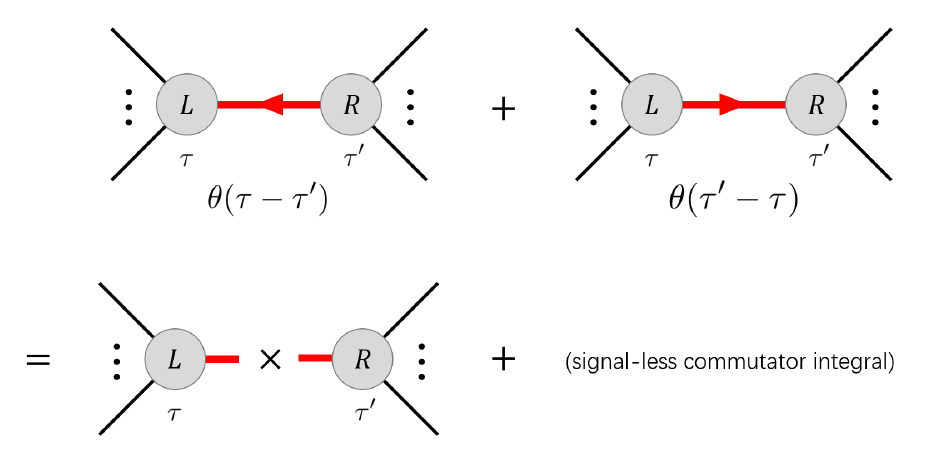
Figure 13 . A cartoon illustration of the cutting rule for CC